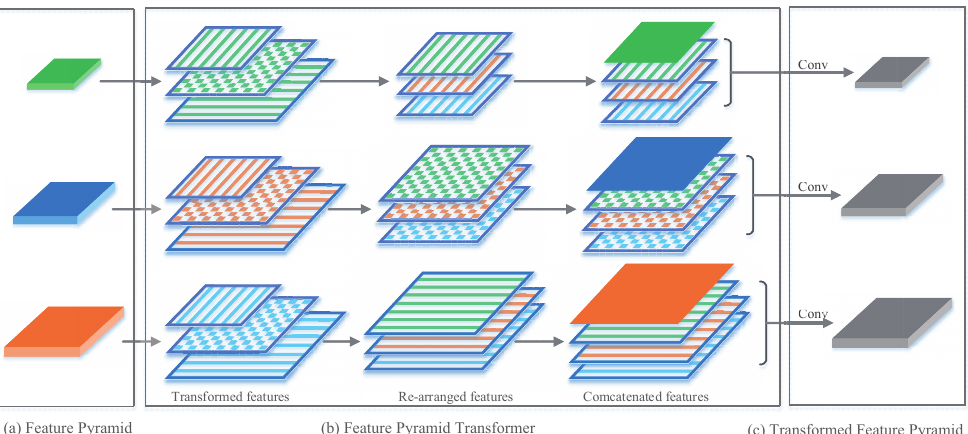
Figure 4. Three transformer steps: ( a ) self-transformer, ( b ) grounding transformer, ( c ) rendering transformer. q i = f q ( X i ) represents the i -th query, k j = f k ( X j ) represents the j -th key, and v j = f v ( X j ) represents the j -th value, where f q ( . ) , f k ( . ) , and f v ( . ) are used to perform queries, keys, and values operations on the feature map, respectively.